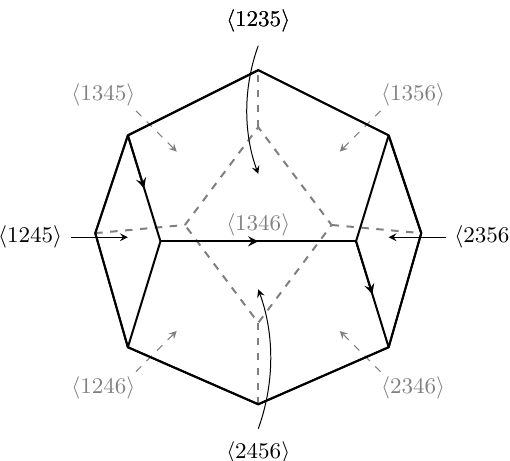
Figure 3. The A 3 Stashe(cid:11) polytope with six pentagonal faces and three square faces, each labelled with the corresponding A -coordinate. The initial cluster corresponds to the vertex at the top left corner at the intersection of the faces labelled by h 1235 i , h 1245 i , h 1345 i . The three-step path leads from the initial cluster to one obtained by a cyclic rotation by one unit.